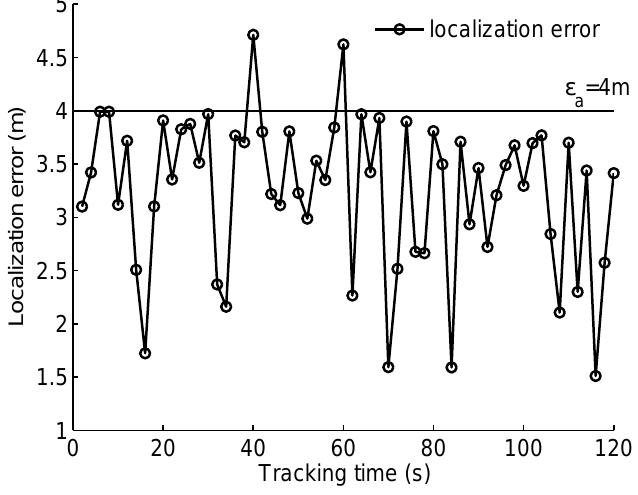
Figure 9 . Tracking result with a localization error upper bound of 4